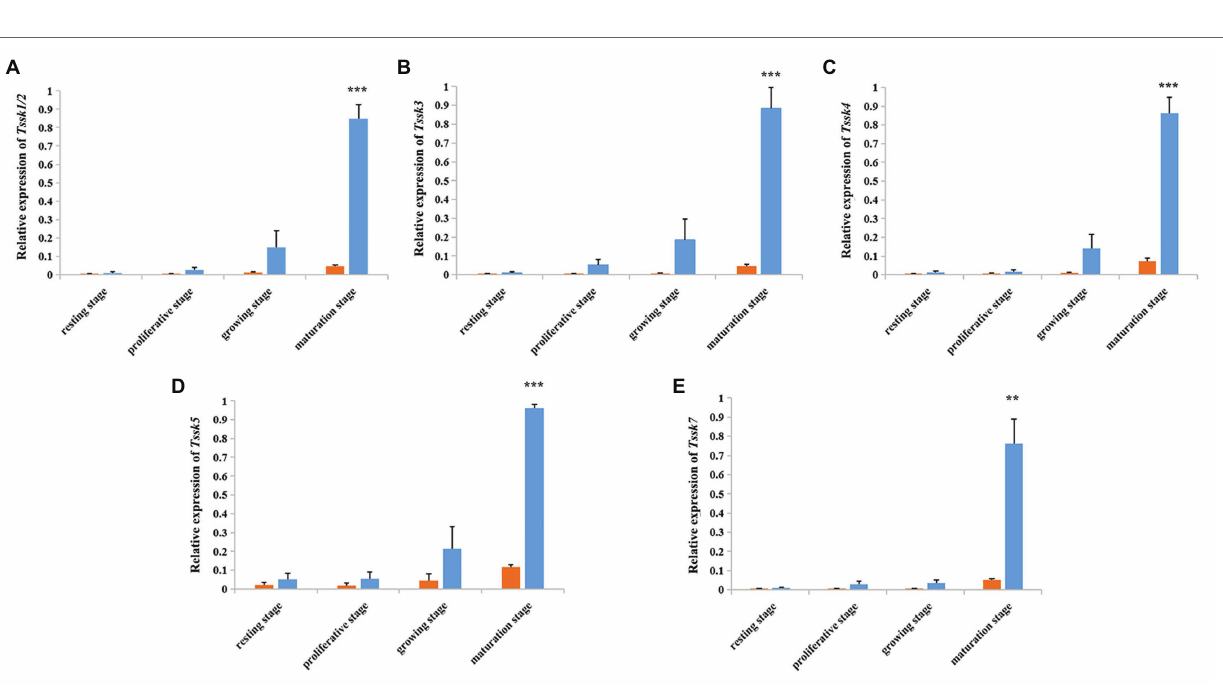
FIGURE 3 | Morphological observation of four developmental stages during gametogenesis of A. irradians . (A–D) The anatomical pictures of bay scallops at resting stage, proliferative stage, growing stage, and maturation stage, respectively. The left shell valve was removed, with anterior towards left. The solid yellow line indicates the boundary of ovary and testis, and the red and blue dotted lines mark the ovary and testis we collected, respectively. (E–H) Represent the histological observation of ovaries at the corresponding stages. (I–L) Represent the histological observation of testes at the corresponding stages.